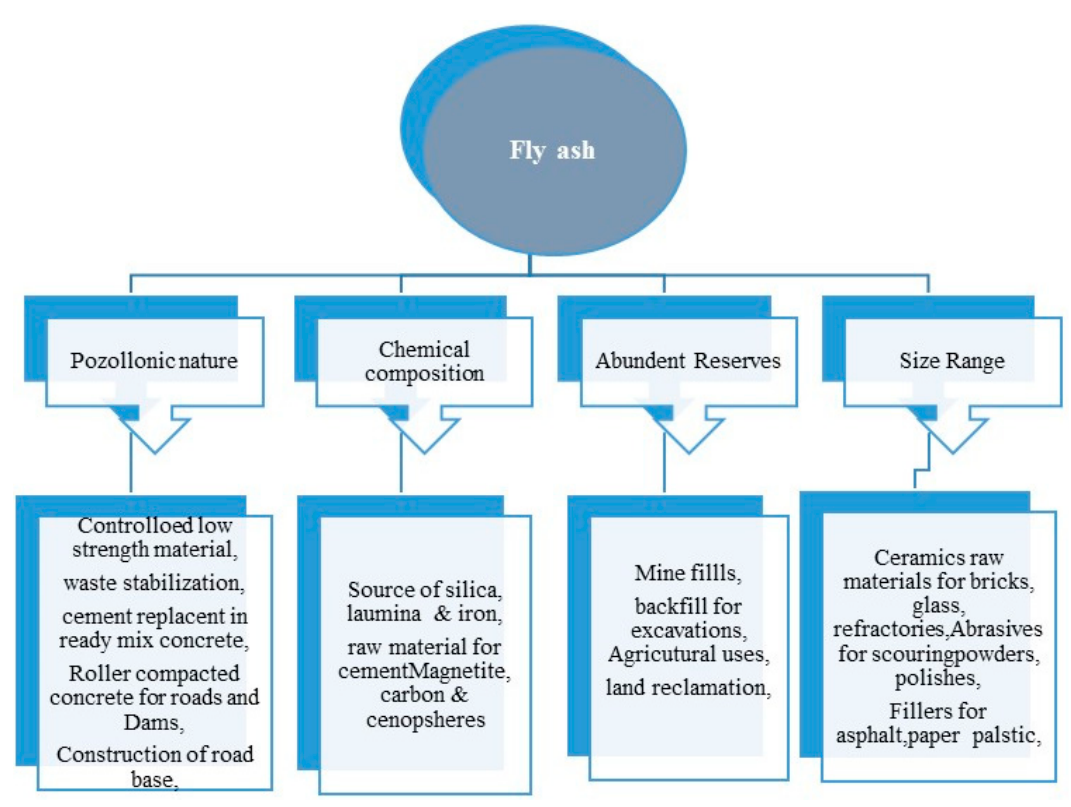
Figure 3. Broad areas of fly ash applications.